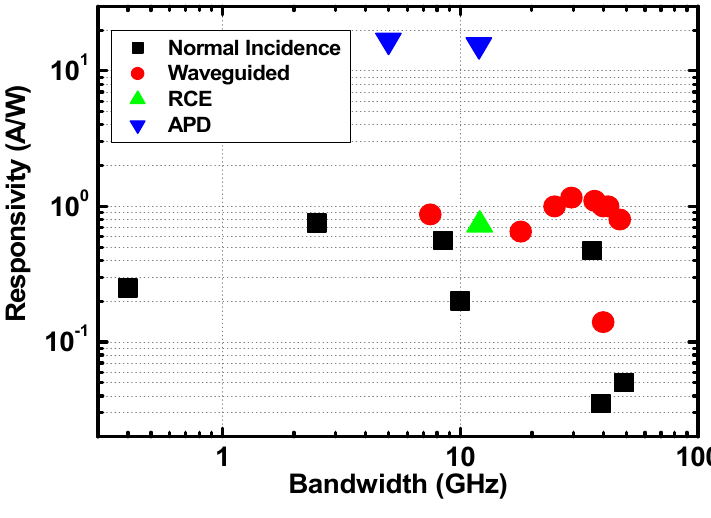
Figure 5. Bandwidth and responsivity of selected Ge photodetectors.